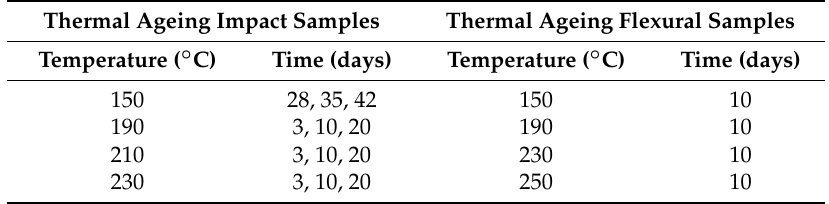
Table 3. Impact characteristic of the drop-weight test.